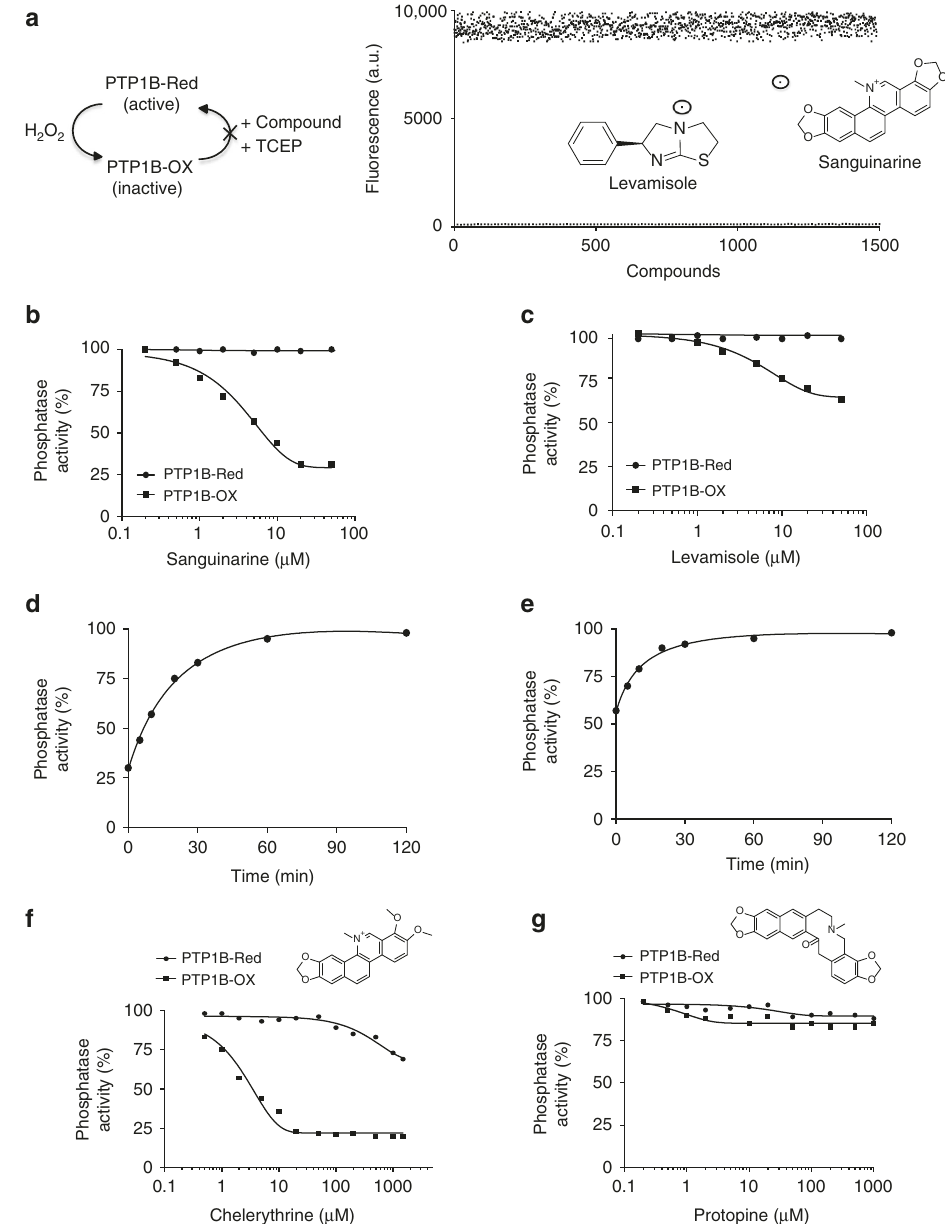
Fig. 4 Identi fi cation and characterization of small molecules that mimic the effect of scFv45. a Reversibly oxidized PTP1B (PTP1B-OX) was generated by incubation with H 2 O 2 in vitro, desalted, then assayed (20 nM) in the presence and absence of individual members of the LOPAC library. In the right panel, each dot represents an activity measurement. With two compounds, the reduction and reactivation of PTP1B-OX by TCEP was attenuated. The structures of these two compounds, levamisole and sanguinarine, are provided. Data are representative of at least two independent experiments ( n = 2). b Increasing concentration of sanguinarine was tested against reduced (circle) and oxidized (square) forms of PTP1B, using DiFMUP as substrate. c Increasing concentration of levamisole was tested against reduced (circle) and oxidized (square) PTP1B, using DiFMUP as substrate. d PTP1B-OX (200 nM) was incubated with sanguinarine (25 µ M) for 5 min and the complex was diluted 100-fold and the activity was monitored for 120 min continuously. e PTP1B-OX (200 nM) was incubated with levamisole (40 µ M) for 5 min and the complex was diluted 100-fold and the activity was monitored for 120 min continuously. f Increasing concentration of chelerythrine, an analog of sanguinarine, was tested against reduced (circle) and oxidized (square) forms of PTP1B, using DiFMUP as substrate. A k i of 5 μ M was calculated for PTP1B-OX and no apparent inhibition of the reduced form was detected. g Increasing concentration of protopine, an analog of sanguinarine, was tested against reduced (circle) and oxidized (square) forms of PTP1B, using DiFMUP as substrate. The compound did not inhibit the reduced or the oxidized form of the protein. Individual data points represent the mean obtained from three separate experiments ( n = 3; b – g